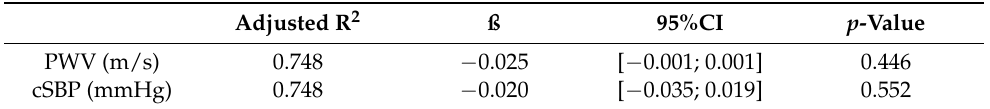
Table 2. Association between surrogates of arterial stiffness and MVPA adjusted for age, sex, BMI z-score, peripheral systolic blood pressure, heart rate and hypertensive